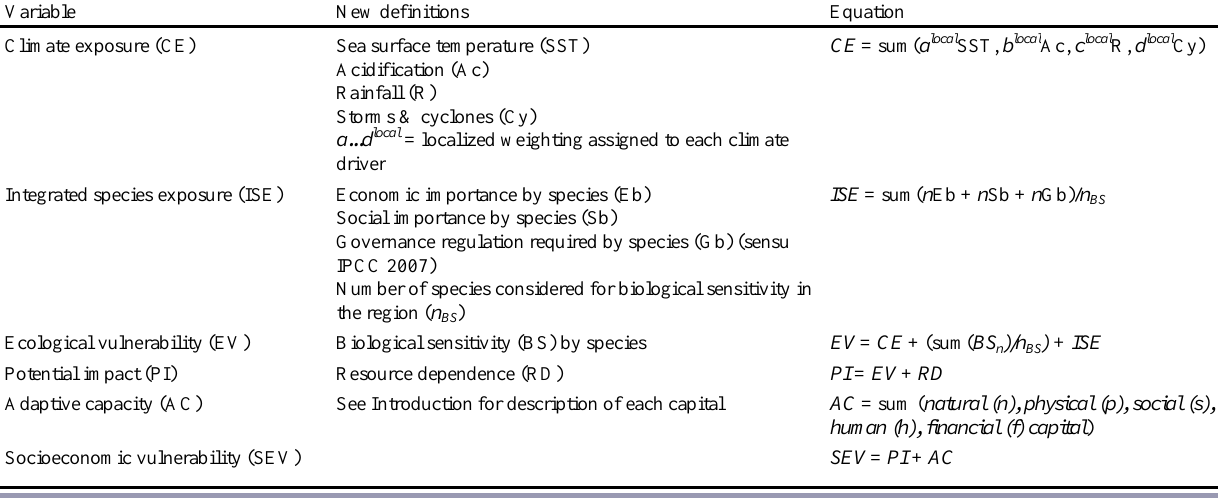
Table 5. Variables, definitions, and equations used to calculate socioeconomic vulnerability of the case study communities. Species used in BS and ISE calculations are from Caputi et al. (2014 a ), Pecl et al. (2014), and Welsh et al. (2014).